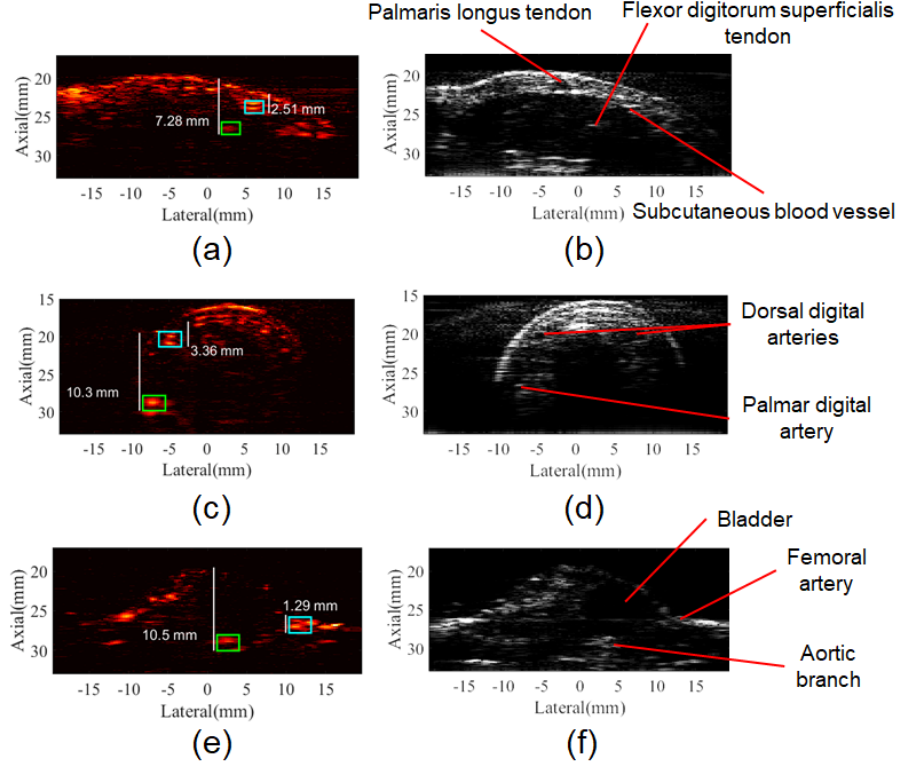
Figure 11. In vivo multiangle long-axis lateral illumination PA and B-mode images. ( a ) PA image and ( b ) B-mode image of the human forearm, anatomical structures such as tendons and subcutaneous blood vessels can be identified; ( c ) PA image and ( d ) B-mode image of the human index finger, the cylindrical shape allows light delivery by the laterals promoting the visualization of the palmar digital artery at depth of 10.3 mm. ( e ) PA image and ( f ) B-mode image of the Balb/Cmouse abdomen, PA signal from an aortic branch at 10.5 mm of depth can be visualized.